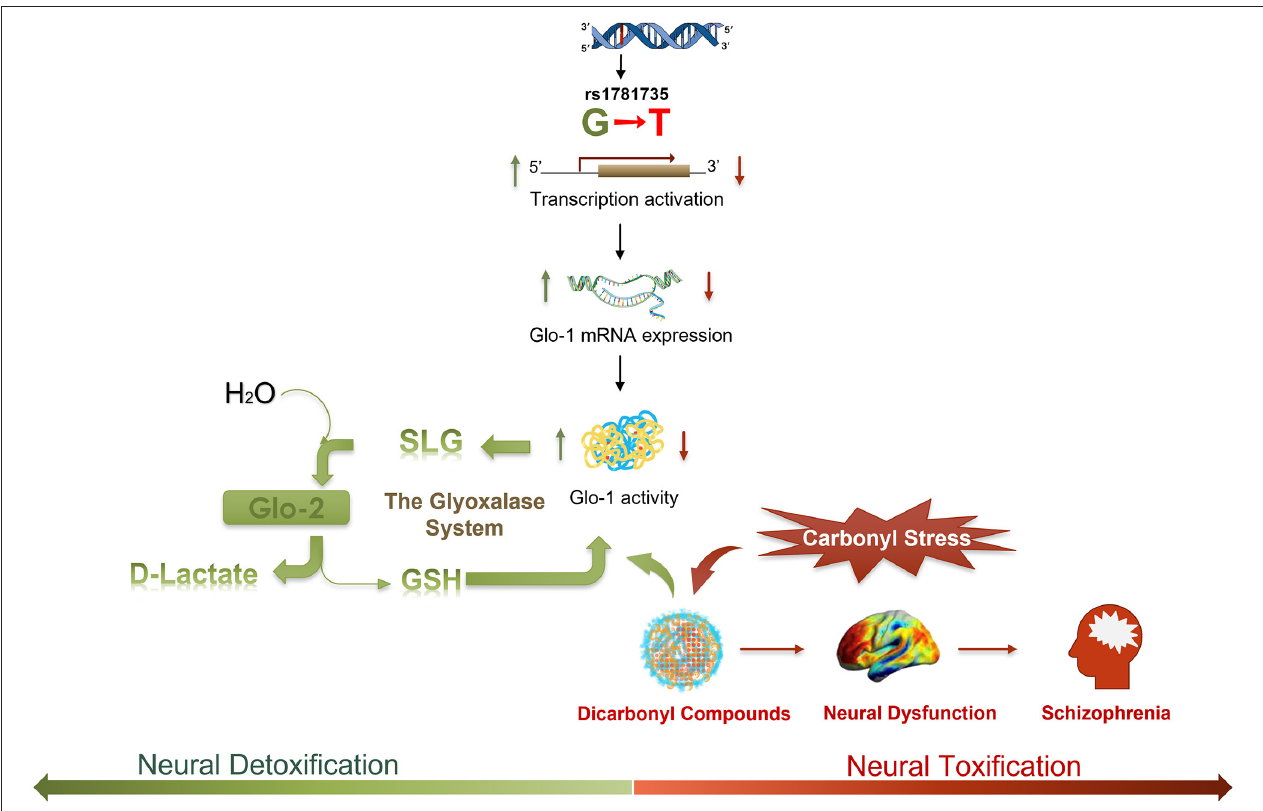
FIGURE 4 | A schematic illustrating the hypothesized regulatory process of the rs1781735 G-T mutation in the etiology of schizophrenia. Dicarbonyl compounds, such as methylglyoxal (MG), as a toxic species could lead to neural dysfunction and symptomatology in schizophrenia. Dicarbonyl compounds can be effectively detoxified via the metabolic pathway of the glyoxalase system. MG reacts with glutathione (GSH) and is converted to S-D-lactoylglutathione (SLG) by Glo-1. SLG is catalyzed into D-lactate by glyoxalase-2 (Glo-2), and GSH is recycled. As a rate-limiting enzyme in the glyoxalase system, Glo-1 plays a critical role in the detoxification of carbonyl stress in